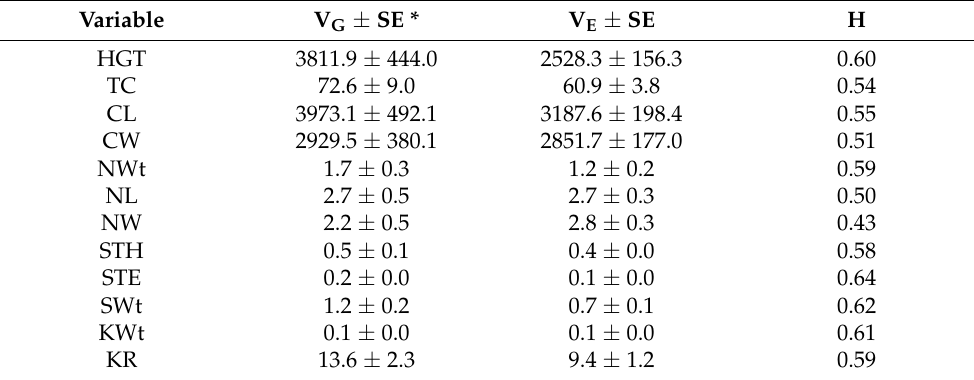
Table 2. Genetic (V G ) and residual (V E ) variances, and broad-sense heritability (H) for tree height (HGT), trunk circumference (TC), canopy length (CL), canopy width (CW), nut weight (NWt), nut length (NL), nut width (NW), shell thickness at hilum (STH), shell thickness at equator (STE), shell weight (SWt), kernel weight (KWt), and kernel recovery